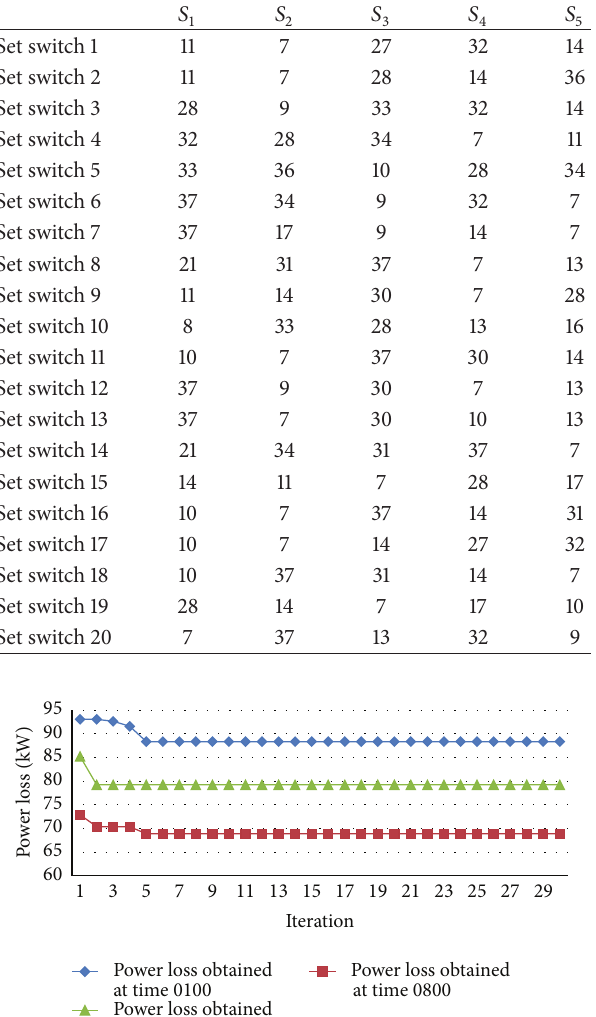
Table 5: Results of nonsimilar effective configurations matrix obtained in Part 2.